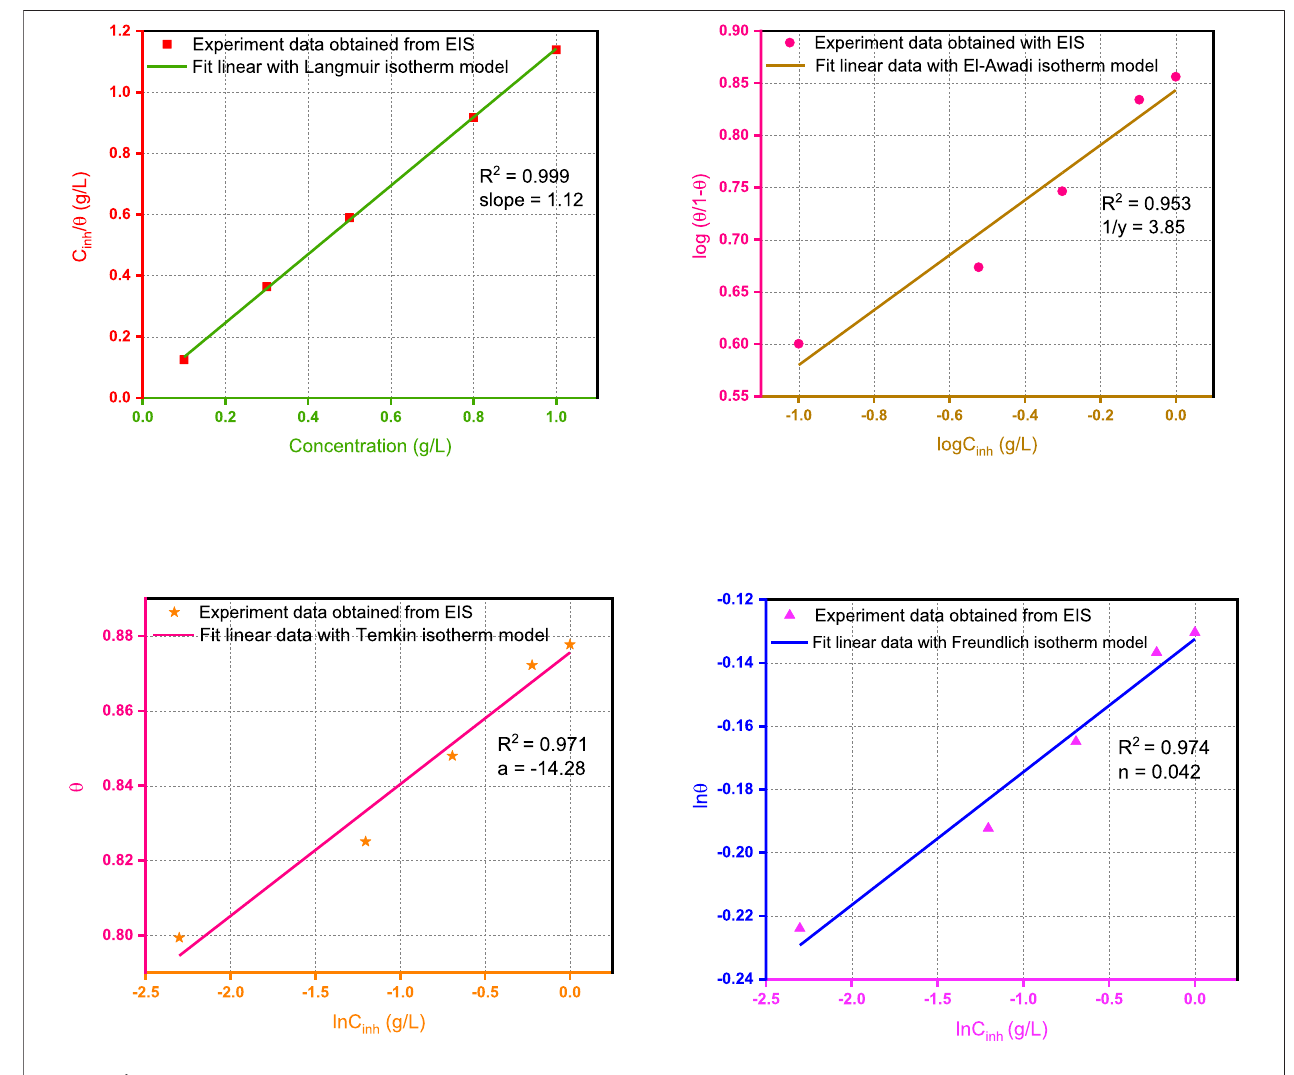
Frontiers in Chemistry |